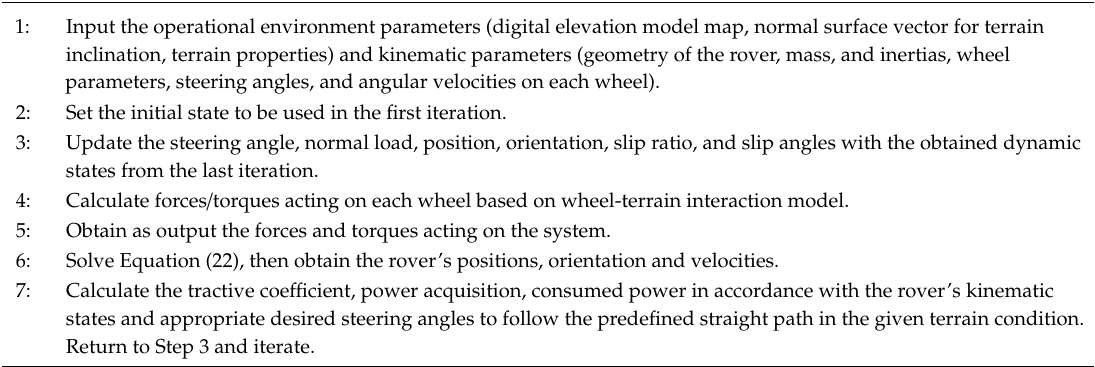
Algorithm 1 Multi-Body Dynamics Simulation Based on the Wheel-Terrain Interaction